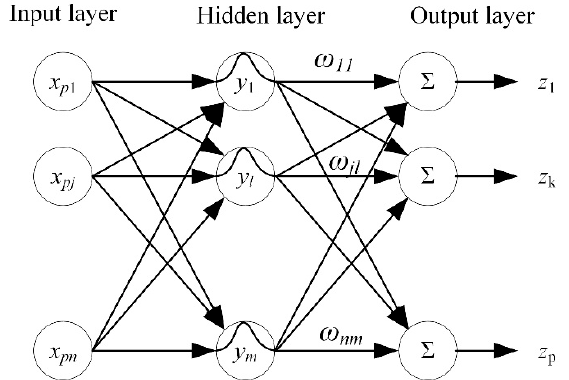
Figure 1. Structure of a radial basis function neural network (RBFNN).